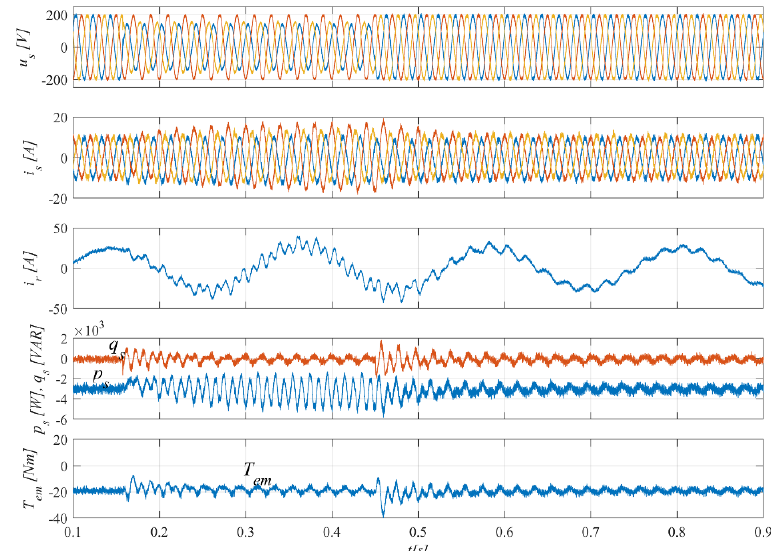
Figure 19. Experimental tests results of DPC showing transient performance in case of asymmetrical grid voltage drop without the feedforward, decoupling mechanism and information about the rotor current value included in the control, Q sref = 0, T emref = − 19.5 Nm. Figure 20 presents experimental results of a case when feedforward and decoupling is applied in control. At t = 0.12 s, an asymmetric voltage drop occurs and it leads to unstable operation even after the voltage asymmetry disappears. Significant undamped oscillations are visible at rotor phase current, instantaneous power signals and electromagnetic torque. The case of DPC with feedback, decoupling and with stator power calculated with rotor current information is given in Figure 21.